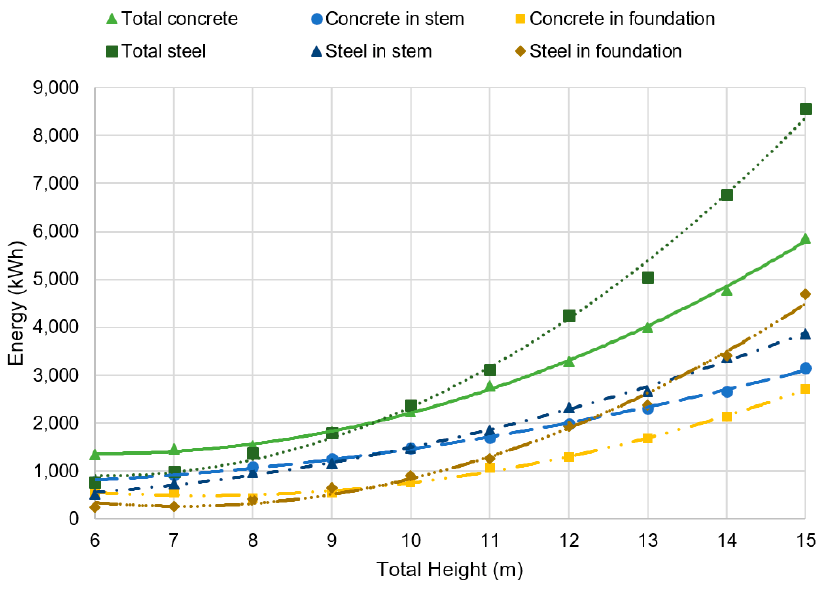
Figure 8. Relation between embodied energy and cost.